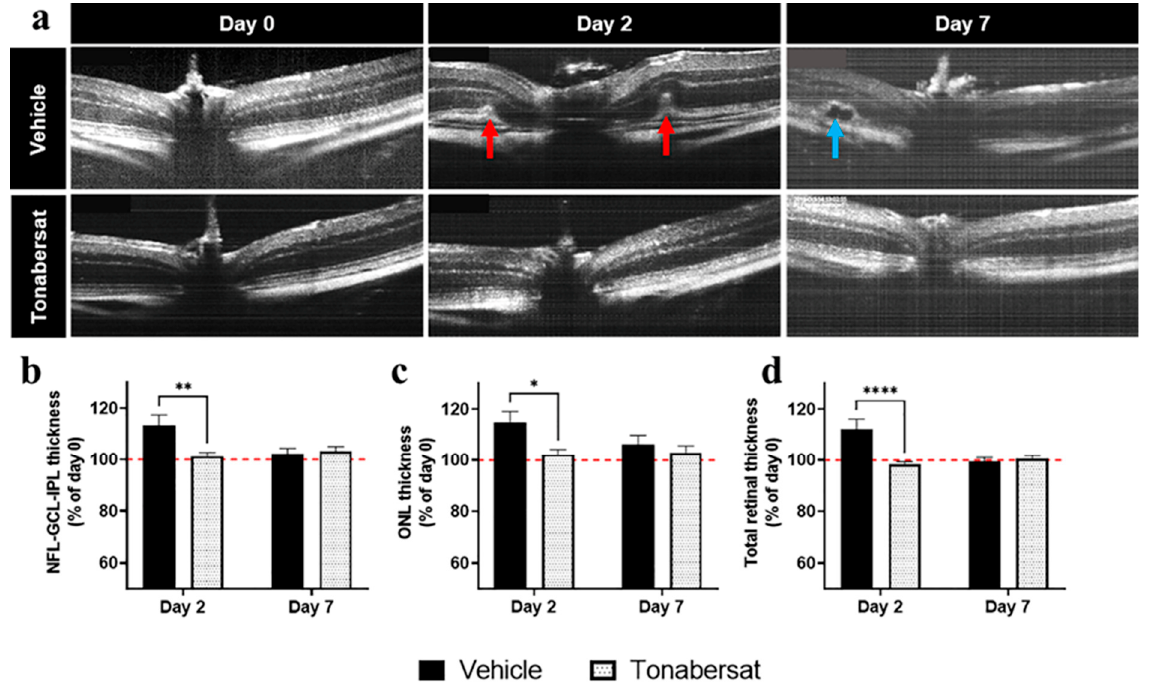
inner plexiform layer; ONL = outer nuclear layer. Statistical analyses were carried out using two-